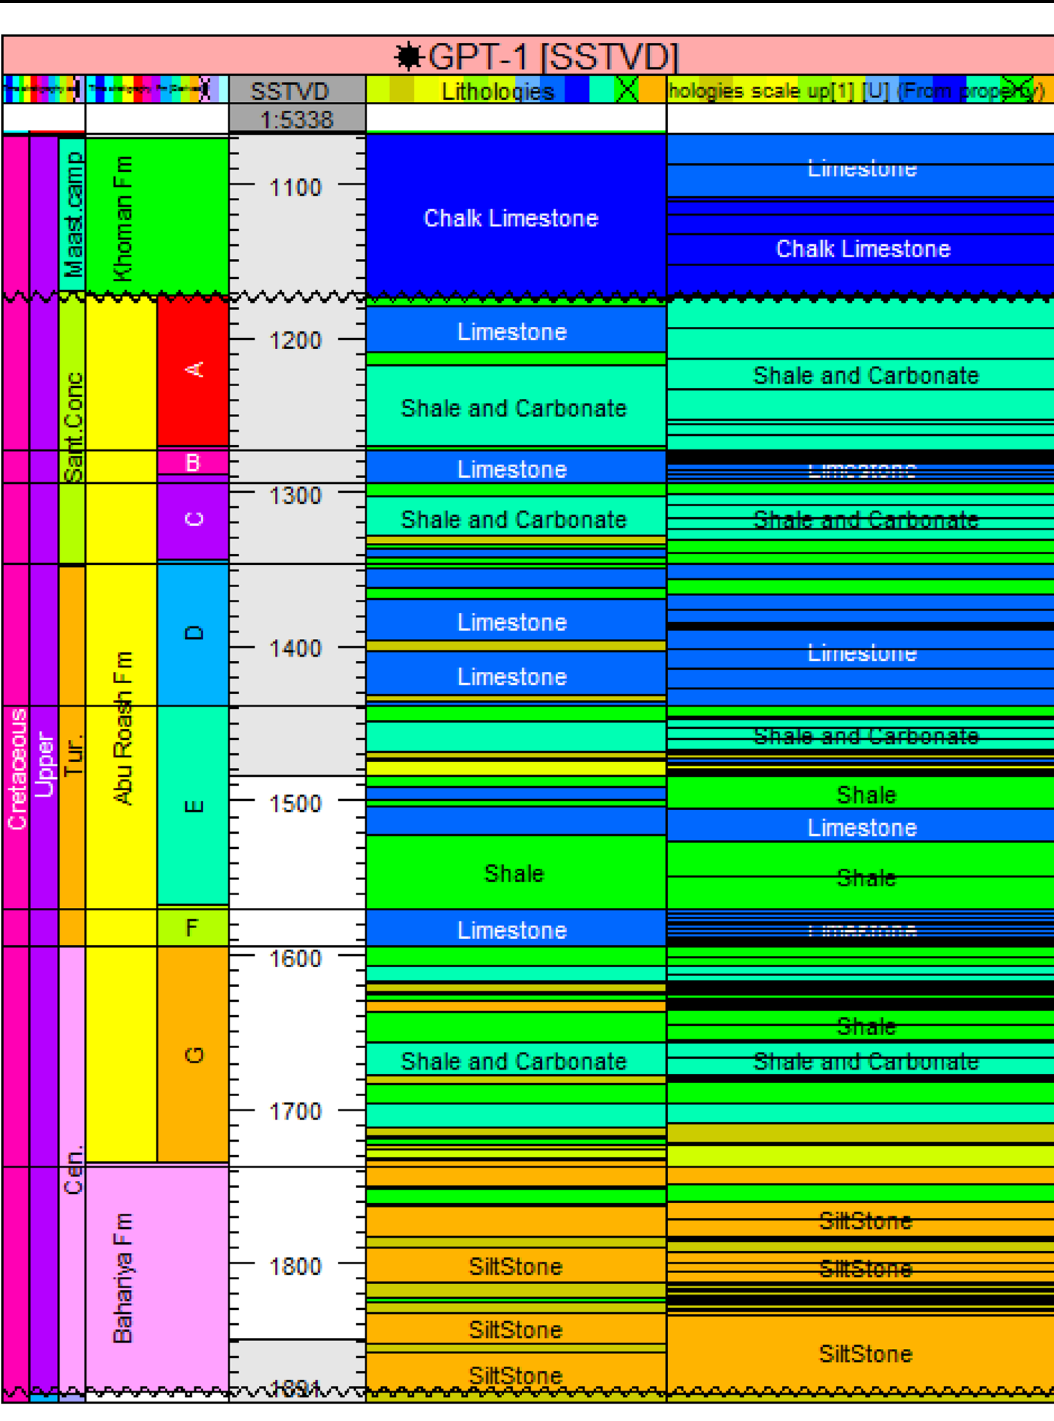
Fig. 13 Scale-up logs for facies modeling in GPT-1